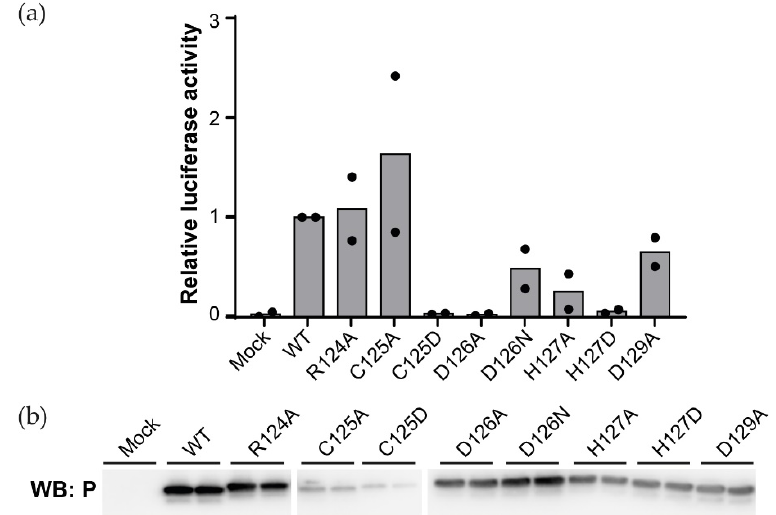
Figure 3. Mutations within the β -strand twist motif of BoDV-1 P modulates viral replication. ( a ) Minireplicon assay using a series of P mutants. The relative luciferase activities are shown as the ratios relative to wild-type P transfected cells (WT). The indicated BoDV-1 P mutants were used as helper plasmids. The dots show mean values (biological replicates; n = 2). ( b ) Detection of BoDV-1 P mutants by western blotting. The whole western blot is shown in Figure S7.